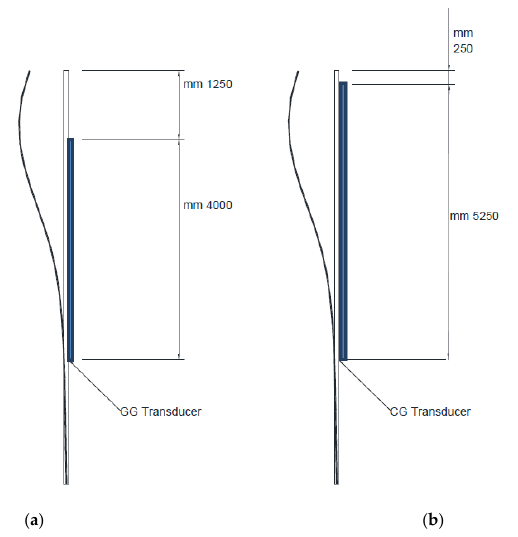
Figure 8. Layouts of vertical inclinometer: ( a ) GG transducer side, ( b ) CG transducer Figure 8. structural schemes of vertical inclinometer.